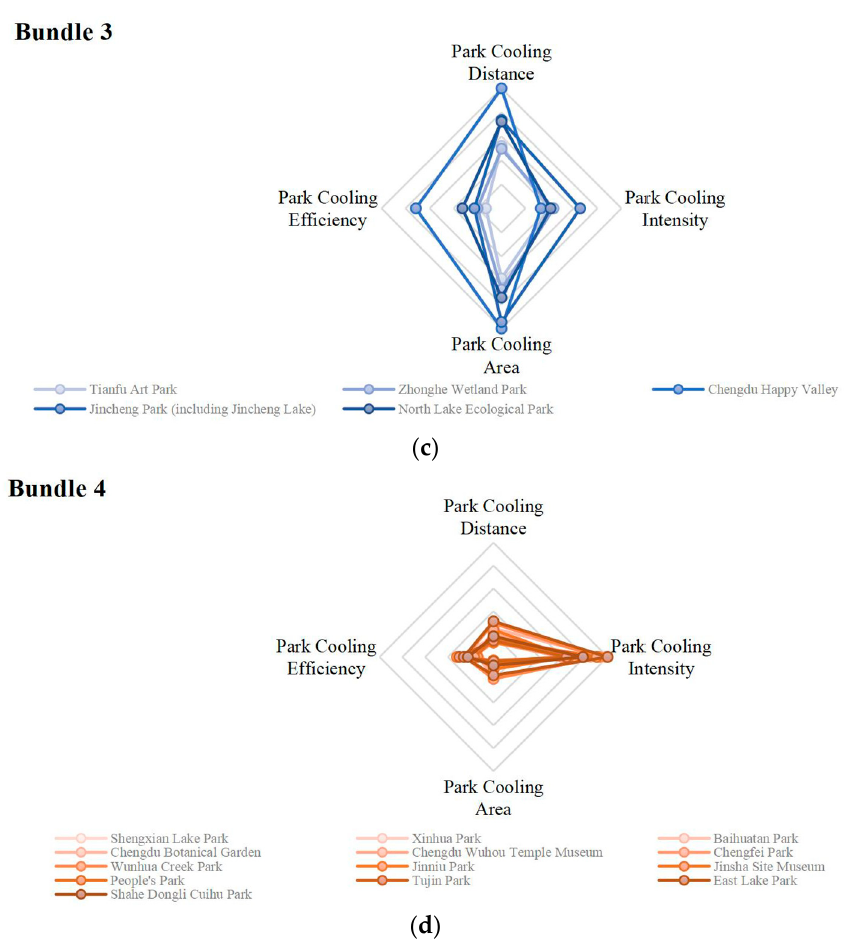
Figure 6. Radar plots of the urban parks’ cooling effect: ( a ) urban park cooling effect bundle 1; ( b ) urban park cooling effect bundle 2; ( c ) urban park cooling effect bundle 3; ( d ) urban park cooling effect bundle 4.